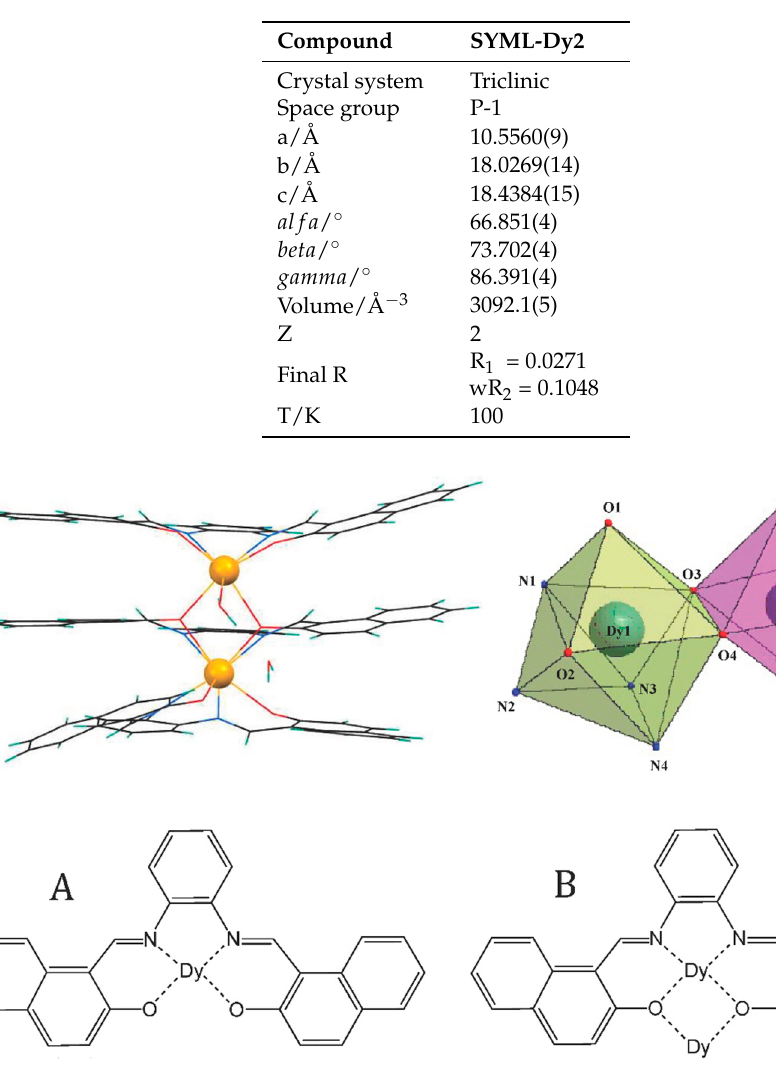
Table 1. Crystal data collection and structural parameters for Syml-Dy2 Complex.